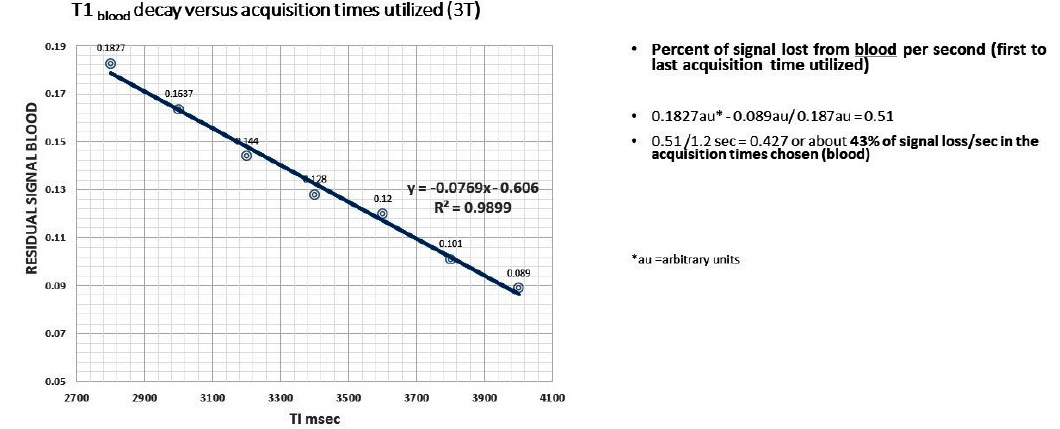
Figure A1. Linear regression of the calculated T1 blood versus acquisition times used. Note the slope is within the range of the normal subjects and R 2 showing high correlation as plotted.